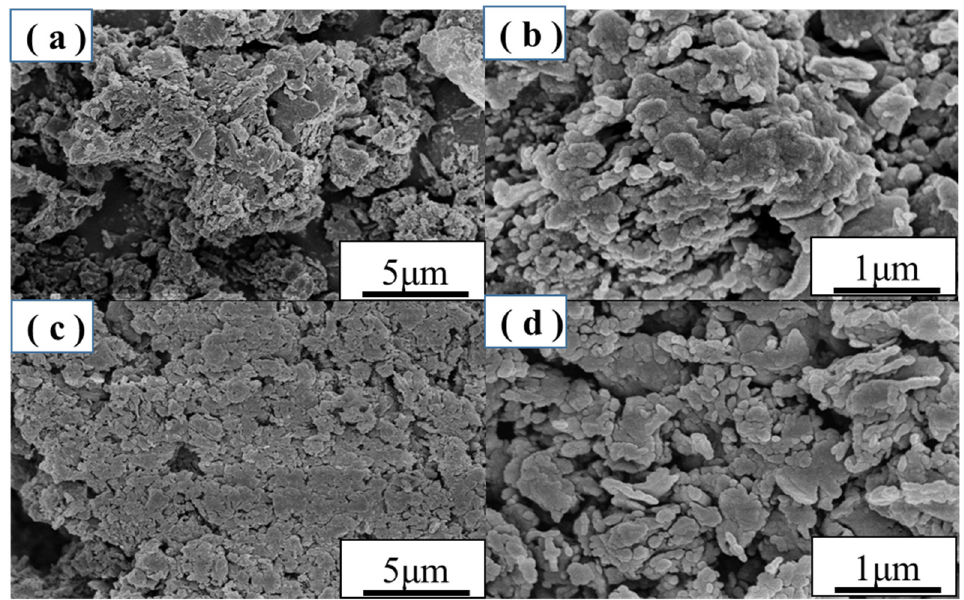
Figure 2. SEM images of ( a , b ) g-C 3 N 4 and ( c , d ) Di/Ur-4:5 composite.